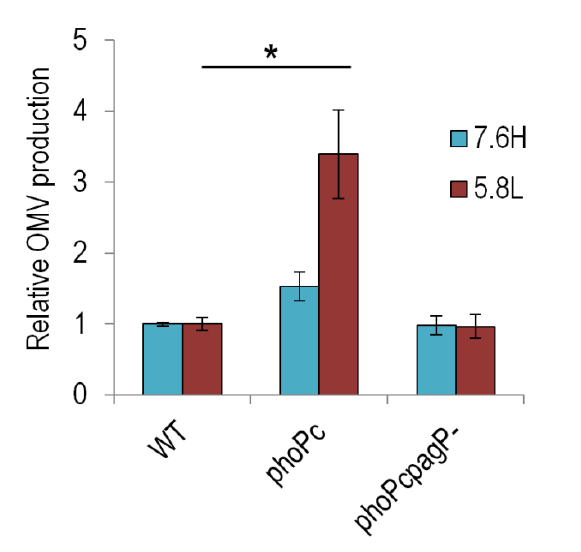
FIGURE 2: Constitutive activation of phoP increases OMV pro- duction in 7.6H and 5.8L conditions. The relative OMV produc- tion, normalized to CFU, during overnight growth of WT (14028s), phoP c (14028s pho-24 ), and phoP c pagP- (14028s pho-24 pagP::TnPhoA ) strains in 7.6H (N-minimal media pH 7.6 10 mM MgSO 4 ) and 5.8L media (N-minimal media pH 5.8 10 µM MgSO 4 ), as calculated for protein content by OMP densitometry. For all conditions, n > 3; *, statistically significant difference for the indi- cated pair, p <